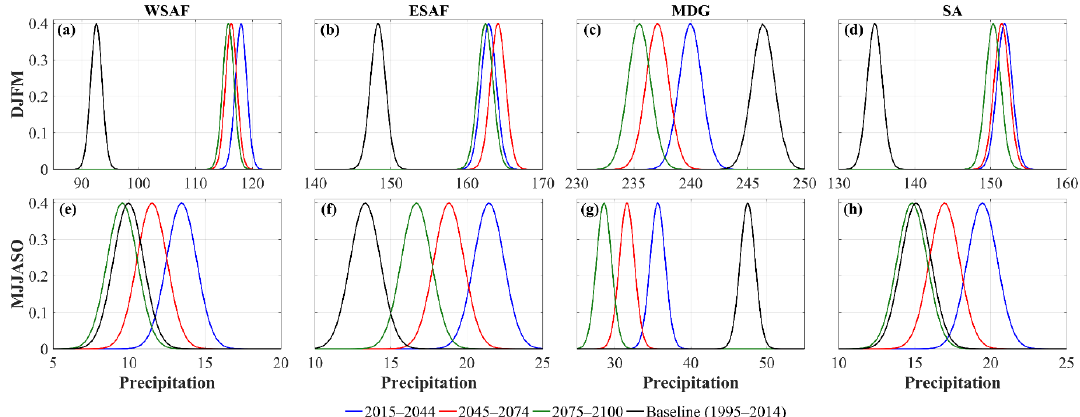
Figure 12. The same as Figure 11, but for